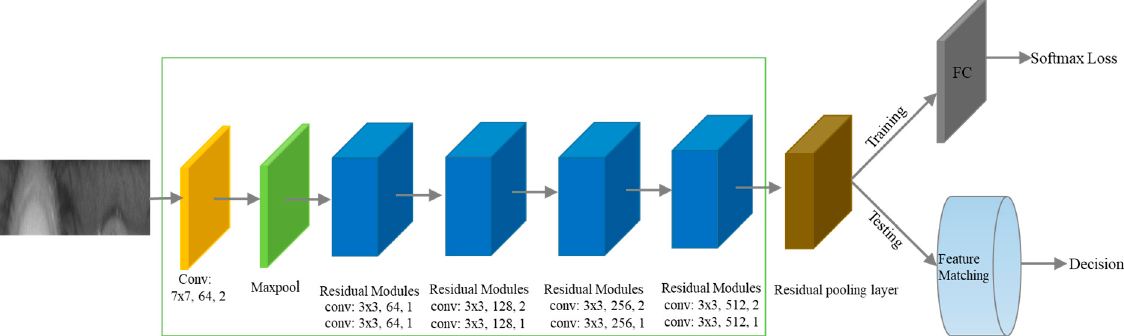
Figure 2. Architecture of the proposed network for iris verification (convolutional layer configuration denoted as kernel size, number of channels, and stride). A CNN integrated with a residual pooling layer is developed for extracting more texture features of the iris. The softmax loss function is used for